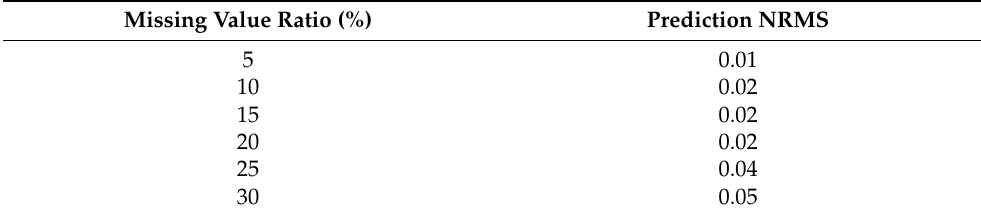
Table 11. Missing data imputation accuracy for RW speed